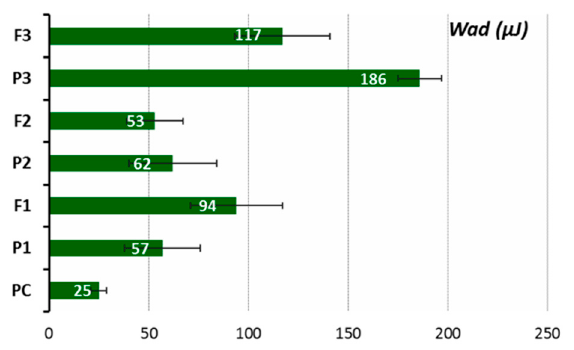
Figure 6. The maximum force of detachment (F max , mN) of placebo (P1–P3) and chitosan tablets with Chelidonii herba lyophilized extract (F1–F3) compared to cellulose acetate paper control (PC) ( n = 4; mean ± SD).